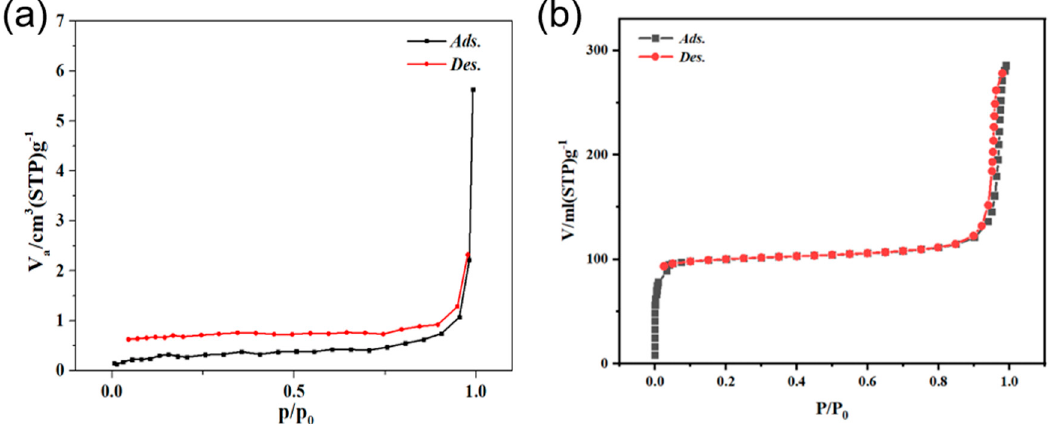
Figure 4. ( a ) The N 2 adsorption − desorption isotherm of BiVO 4 nanorods; ( b ) the N 2 adsorption − desorption isotherm of BiVO 4 @ZIF − 8.